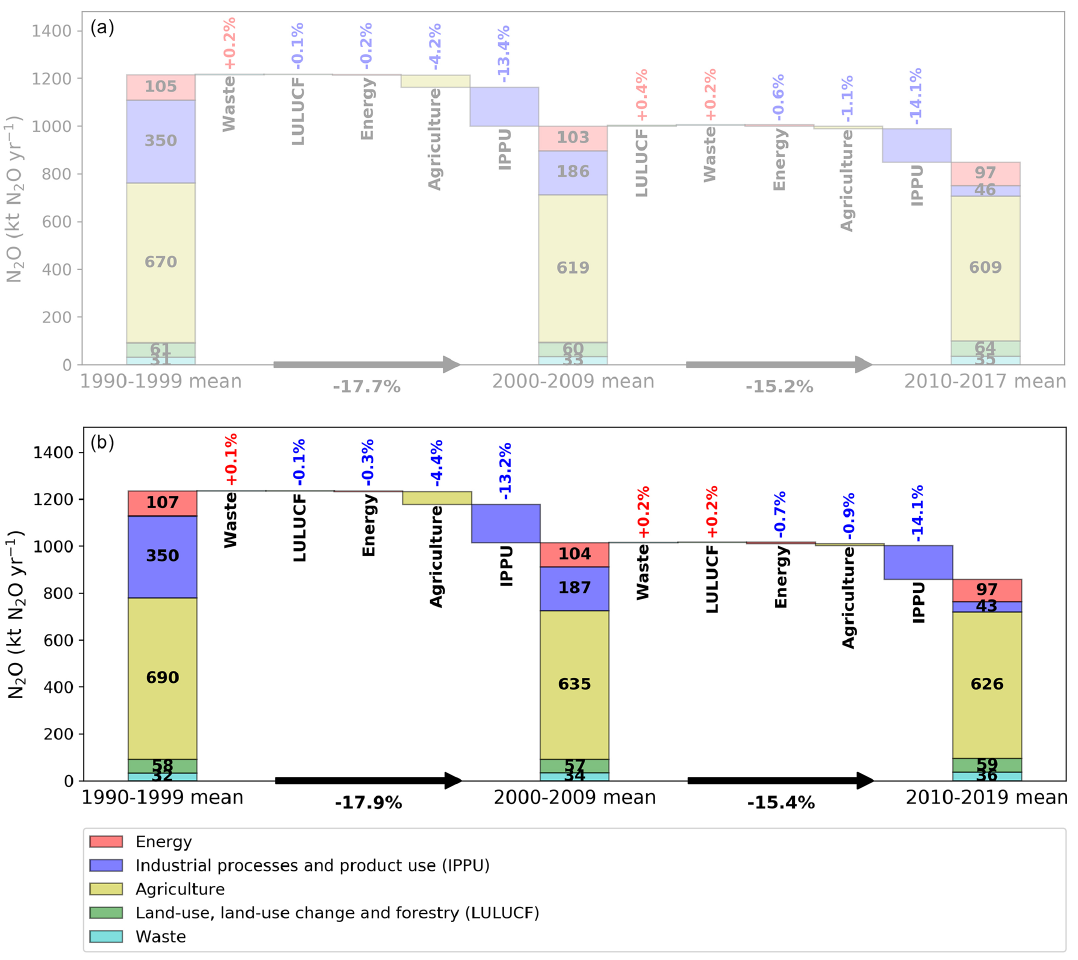
Figure 11. The contribution of changes (%) in N 2 O anthropogenic emissions in the five sectors to the overall change in decadal mean for the EU27 + UK as reported to UNFCCC. Panel (a) shows the previous NGHGI data in Petrescu et al. (2021), and panel (b) depicts data from UNFCCC NGHGI (2021). The three stacked columns represent the average N 2 O emissions from each sector during three periods (1990– 1999, 2000–2009 and 2010–2019), and percentages represent the contribution of each sector to the total reduction percentages between